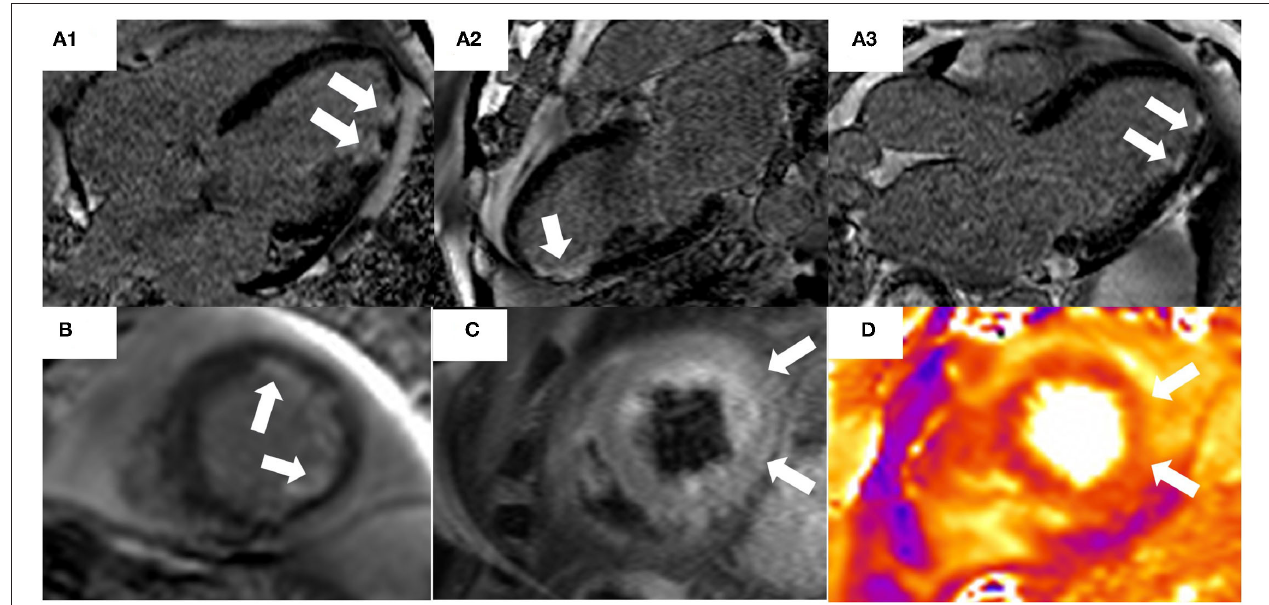
FIGURE 1 | 74-year old male presented with chest pain and troponin rise with lateral T-wave inversion on electrocardiogram. Invasive coronary angiography demonstrated non-obstructed coronary arteries. CT pulmonary angiography was also negative for pulmonary embolus. A Cardiac MRI demonstrated evidence of myocardial infarction with typical ischemic pattern of subendocardial late gadolinium enhancement (LGE) [white arrows, (A1–A3) : 4 Chamber, 2 Chamber, 3 Chamber, (B) short axis] in the apical inferior and lateral segments. Areas of high signal on T2-STIR imaging (C) and T2-mapping (D) correlating to the area of infarction from LGE imaging and the ECG abnormalities, suggesting acute myocardial edema due to acute myocardial